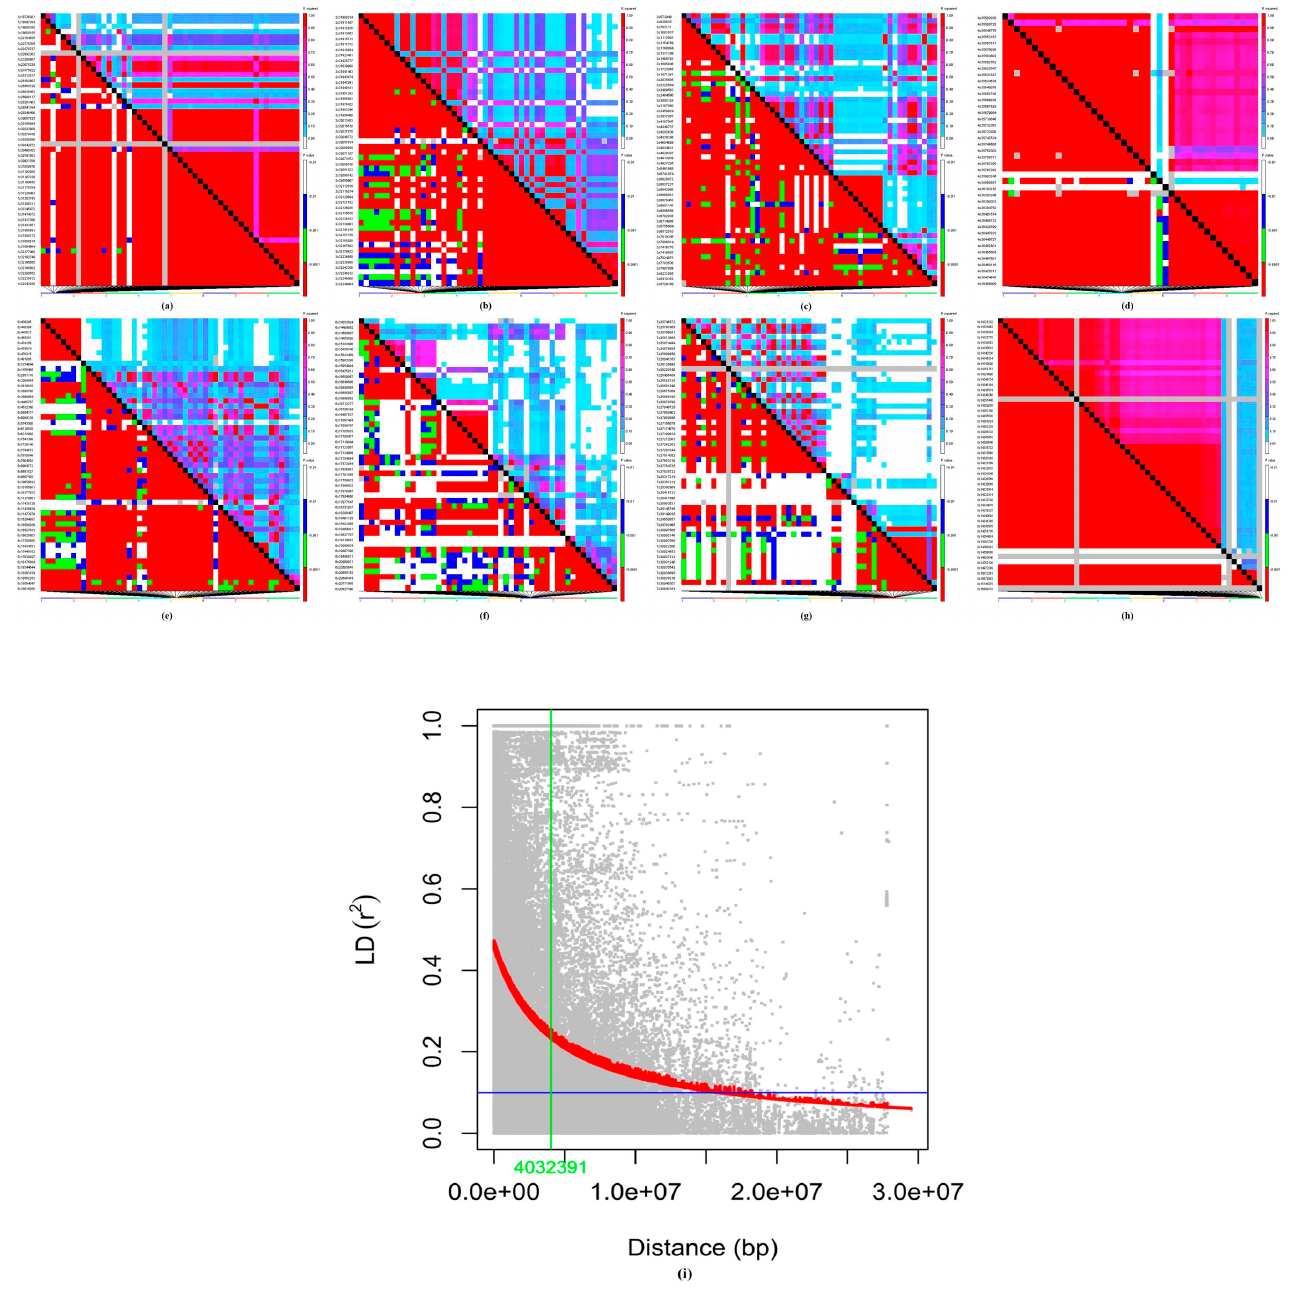
Figure 3. Linkage disequilibrium (LD) patterns on eight chromosomes ( a – h ) across the chickpea genome, genotyped with 4603 SNPs (MAF ≥ 0.05). The squared correlation coefficients ( r 2 ) for each pair of markers are presented in the upper triangle and their corresponding tests in the lower triangle. White, p < 0.01; blue, 0.01 > p > 0.001; green, 0.001 > p > 0.0001; and red, p < 0.0001. ( i ) LD decay plot with average r 2 value on y -axis and the physical distance between markers (bp) on x − axis.